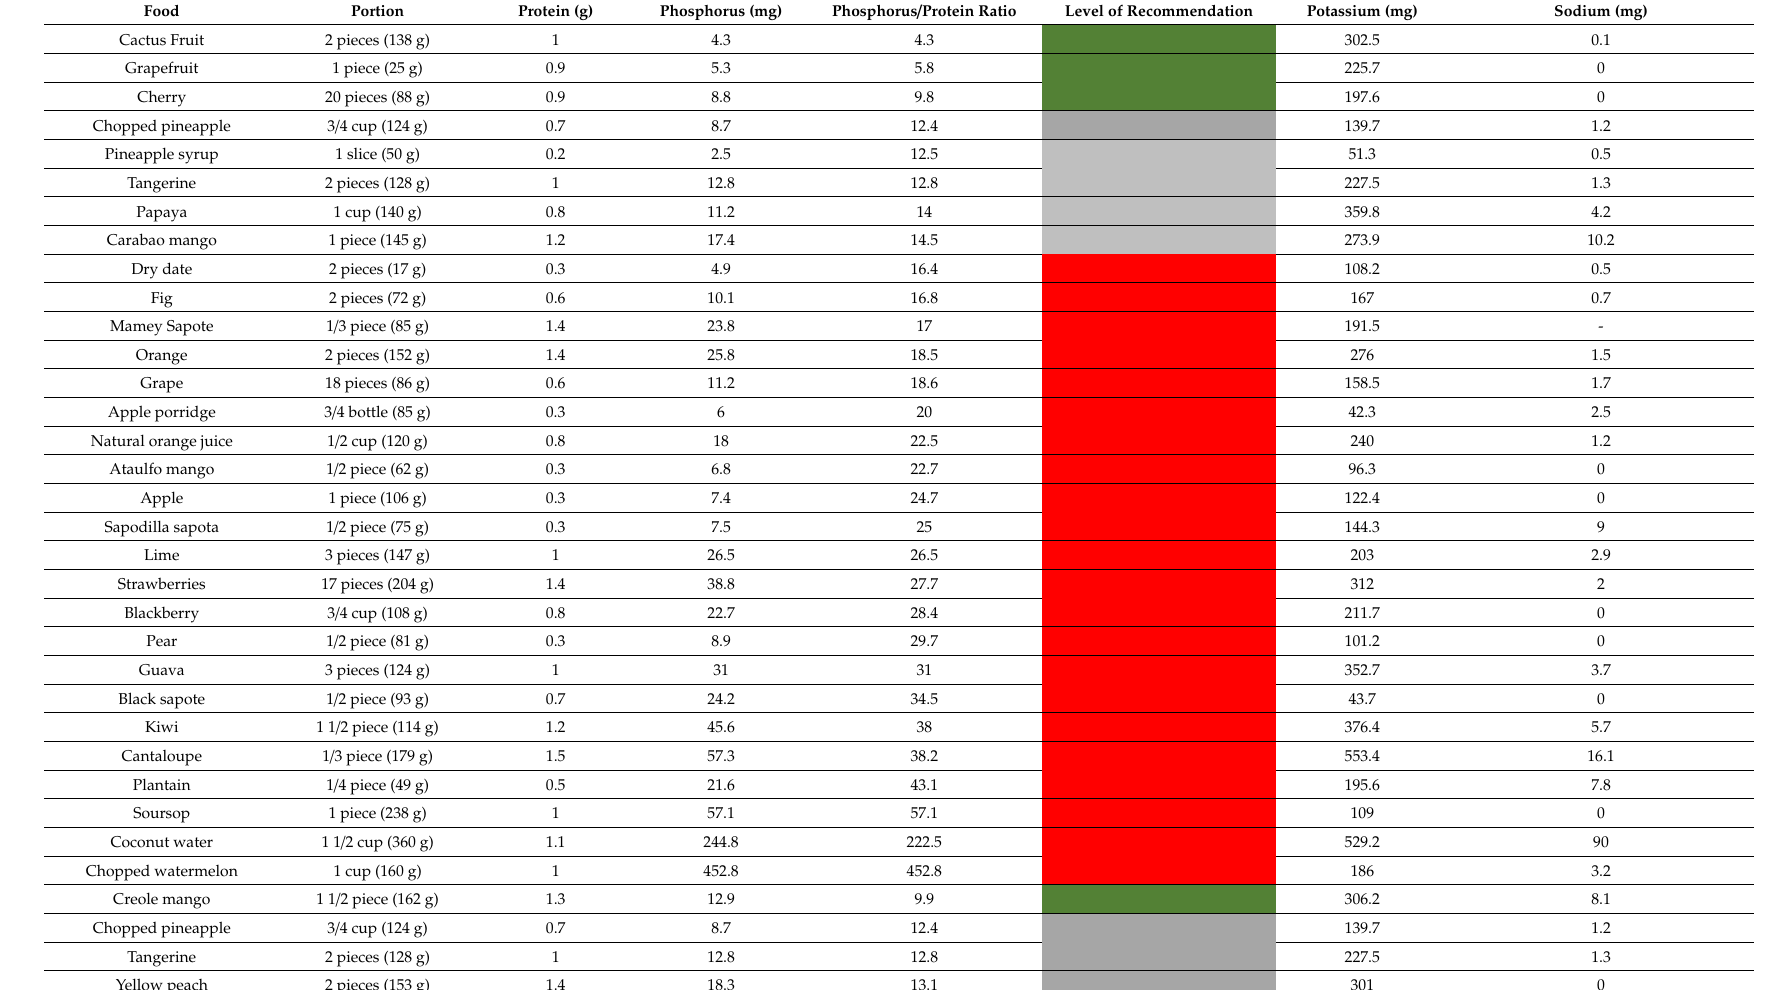
Table 1. Food table for Mexican population with phosphorus / protein ratio per